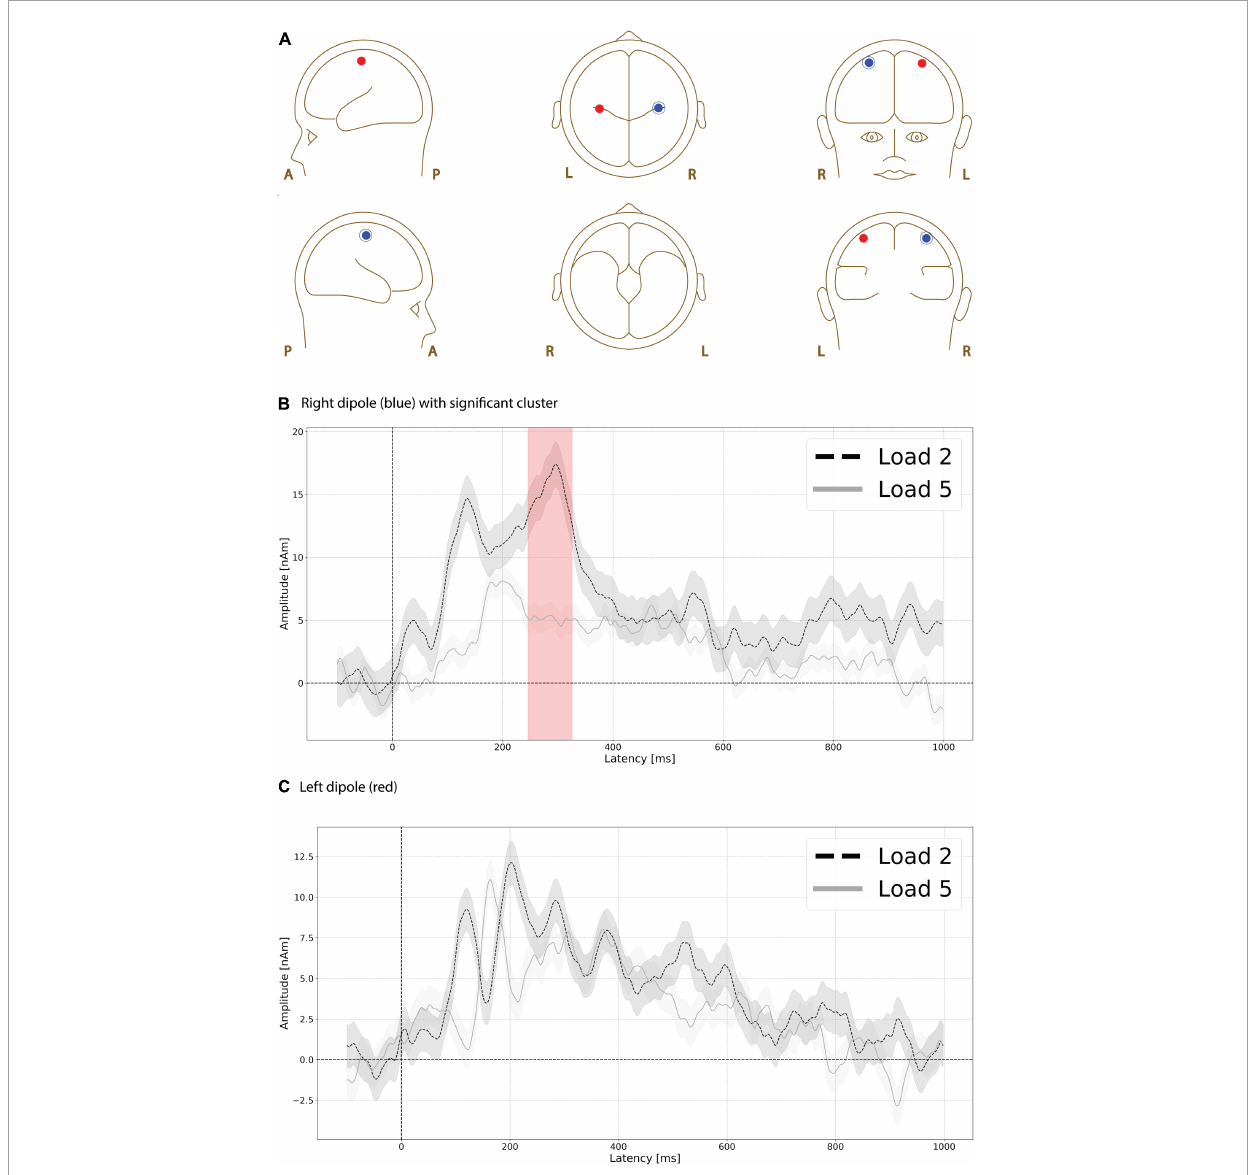
FIGURE6 Functional magnetic resonance imaging (fMRI)-weighted motor cortex source group EEG waveforms during the delay period. Head plot of asymmetric dipole clusters located in left motor cortex (red) and right (left) hemispheres (A) . Evoked responses were significantly higher ( p < 0.01) in amplitude during the low compared to high load delay period in right motor cortex at ∼ 250 ms ( B , red shading), but no significant differences were found at any time interval in left motor cortex (C) . Lines are mean amplitude with shaded error bars representing ± 95% confidence